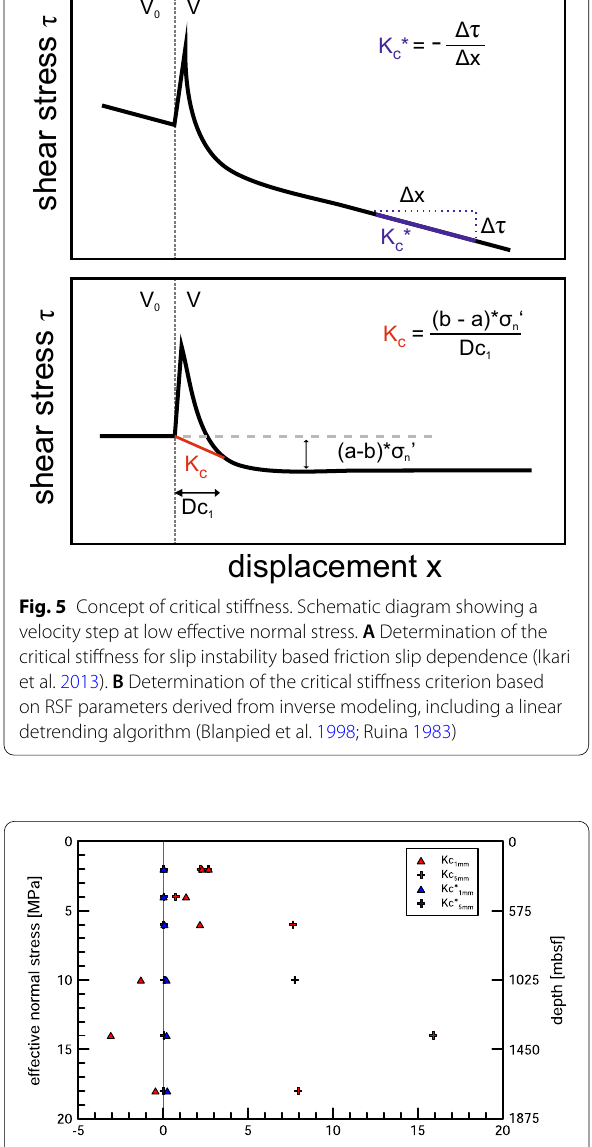
calculated K c and K c * values over both 1 and 5 mm of shear displacement. At high effective normal stresses, K c1mm is negative and transitions to positive values between 6 and 10 MPa effective normal stress (Fig. 6), which is due to the change from velocity-weakening to velocity-strengthening behavior. Because the surround- ing stiffness K is always positive, a negative critical